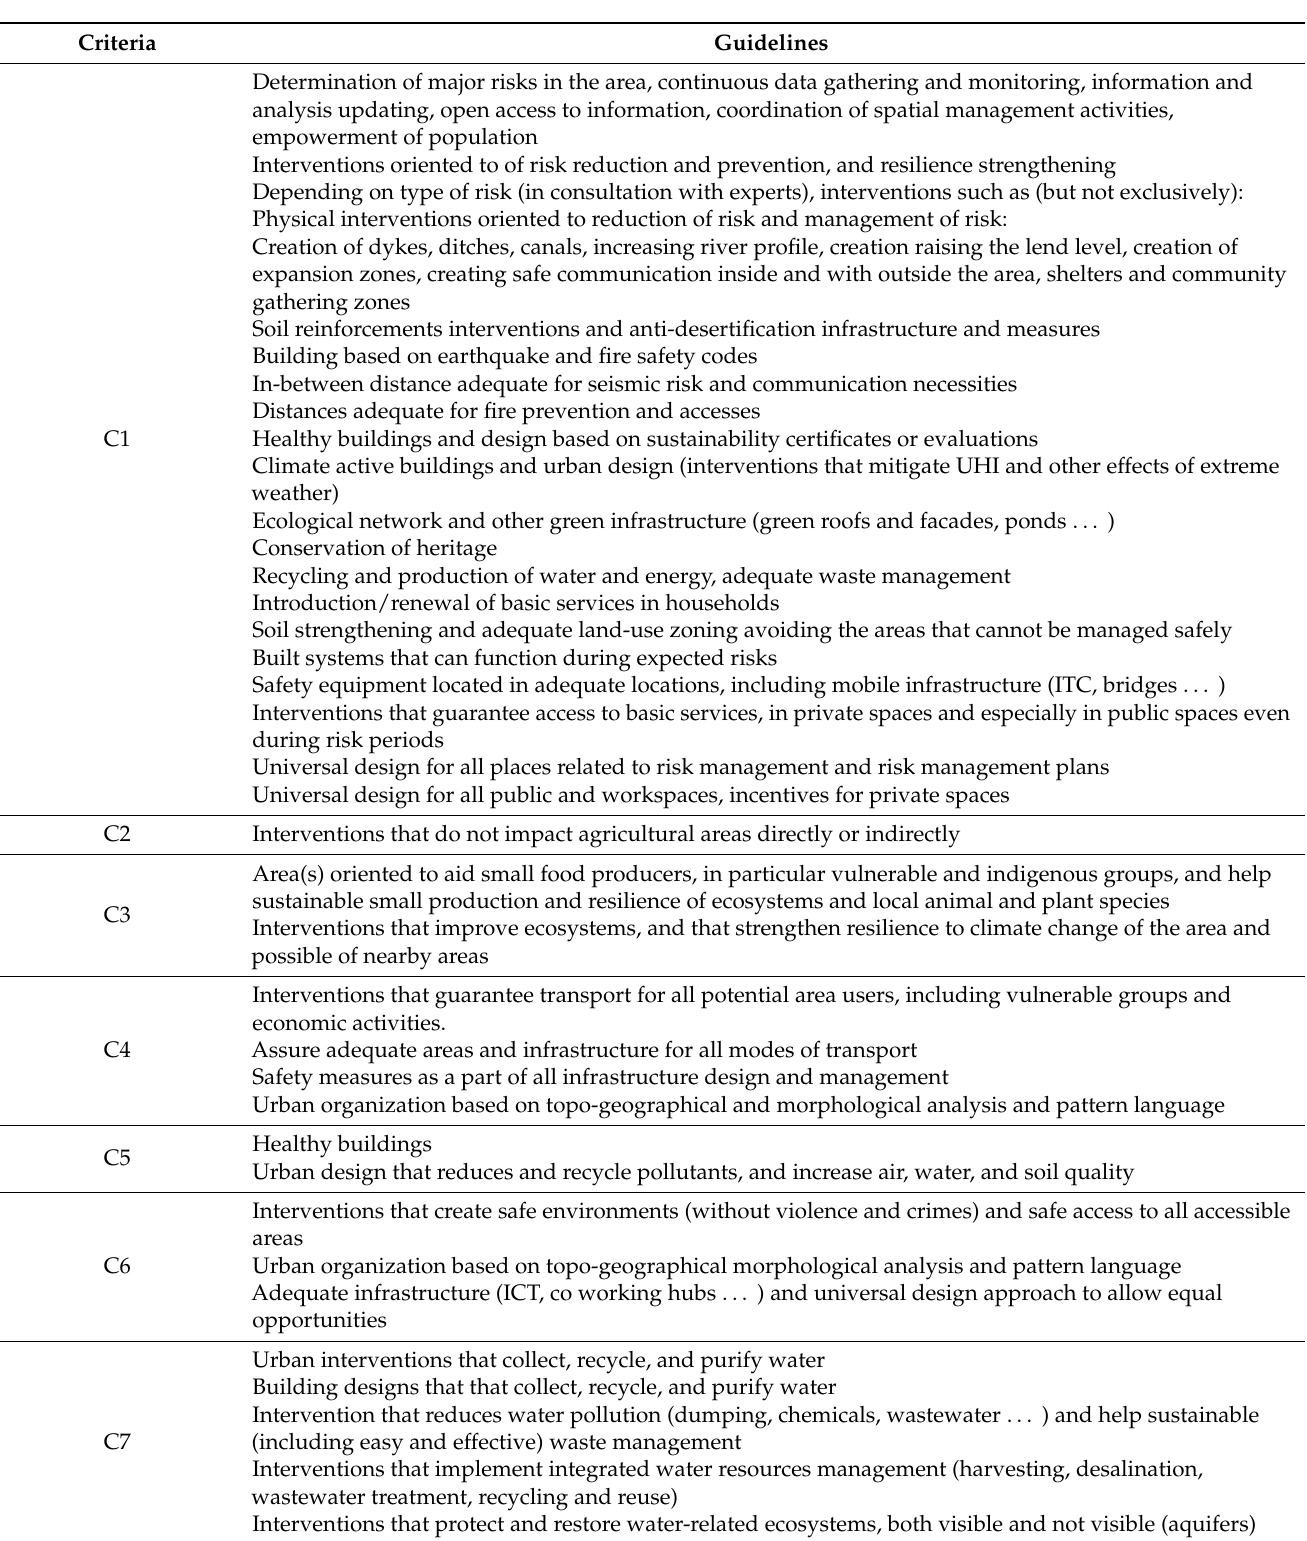
Table A1. Holistic Implementation Guidelines for lower levels of spatial planning, urban and building